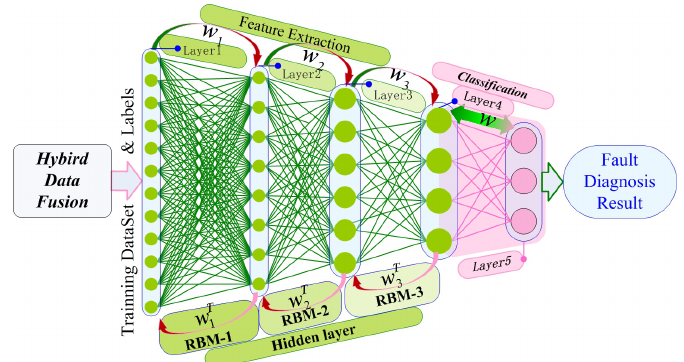
Figure 4. HDBN architecture.